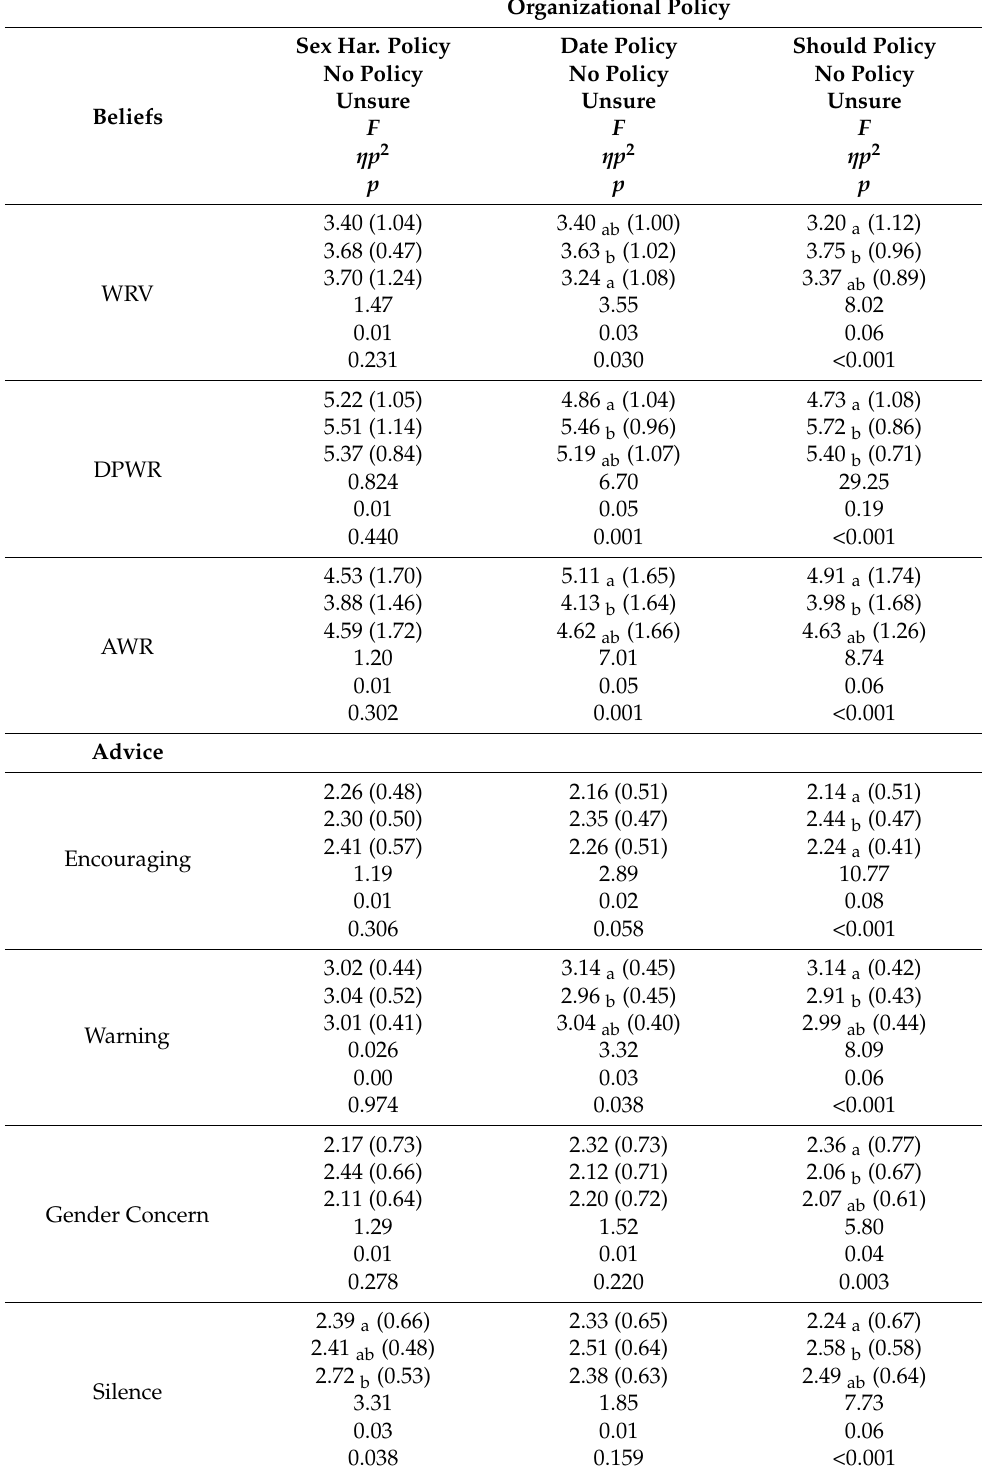
Table 5. Difference in workplace romance beliefs and advice based on organizational